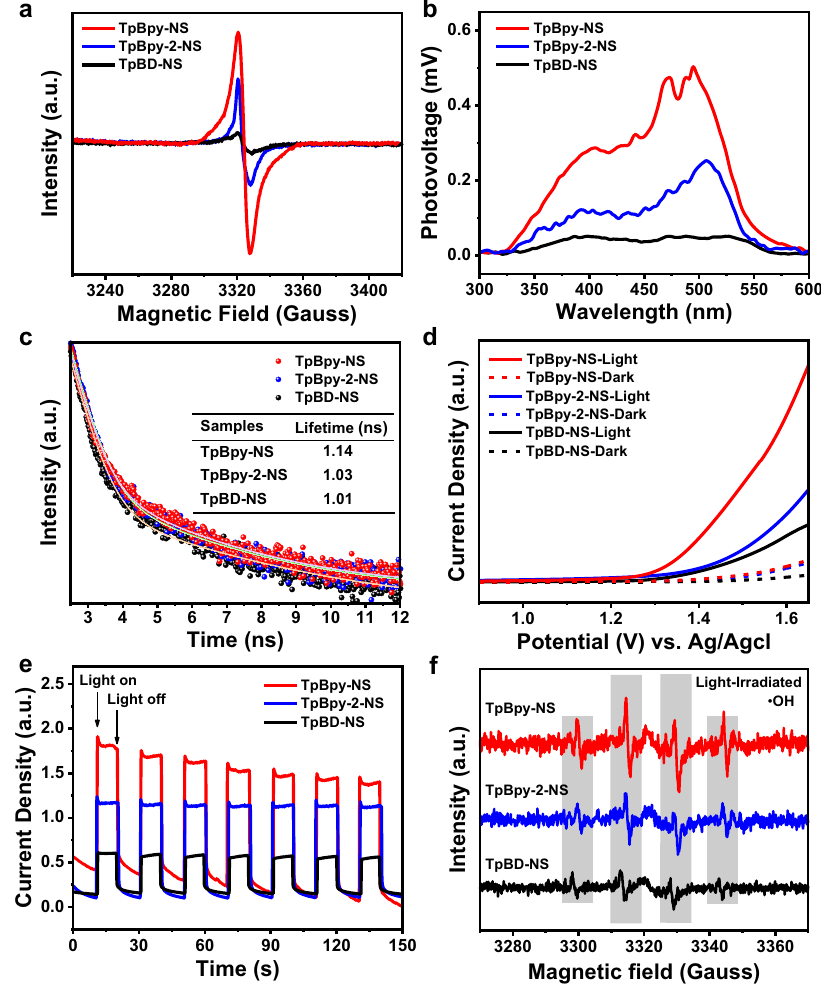
Fig. 4 | Photophysical and photochemicalpropertiesofCOFs-NS. a EPR spectra under illumination, b SS-SPS spectra, c time-resolved PL spectra, d I − V curves in